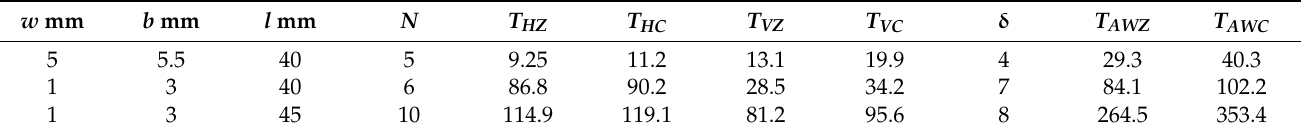
Table 2. Example lower and upper estimates of labyrinthine slit